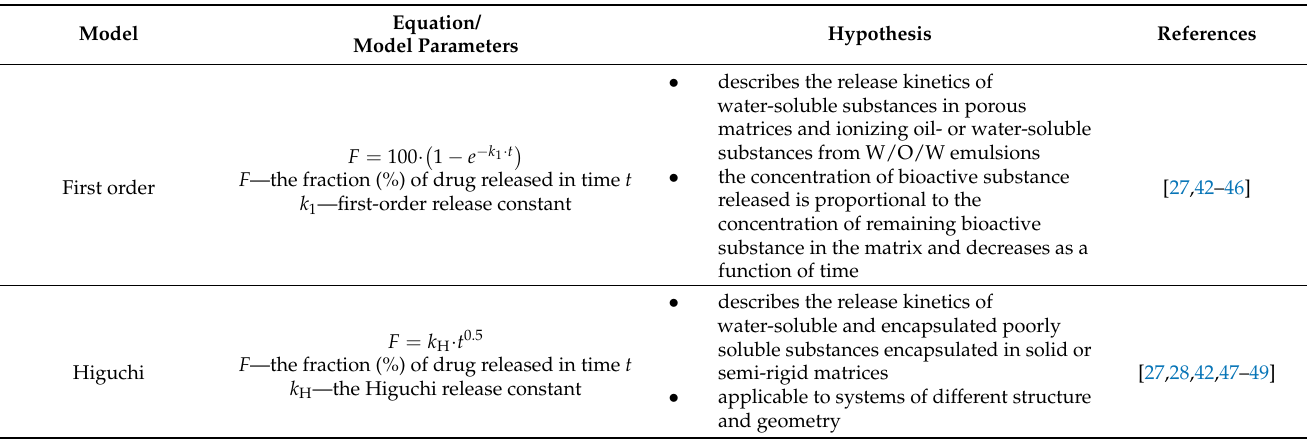
Table 2. Mathematical models used for the modeling of the release of total phenolic compounds from encapsulated grape pomace extracts by ionic